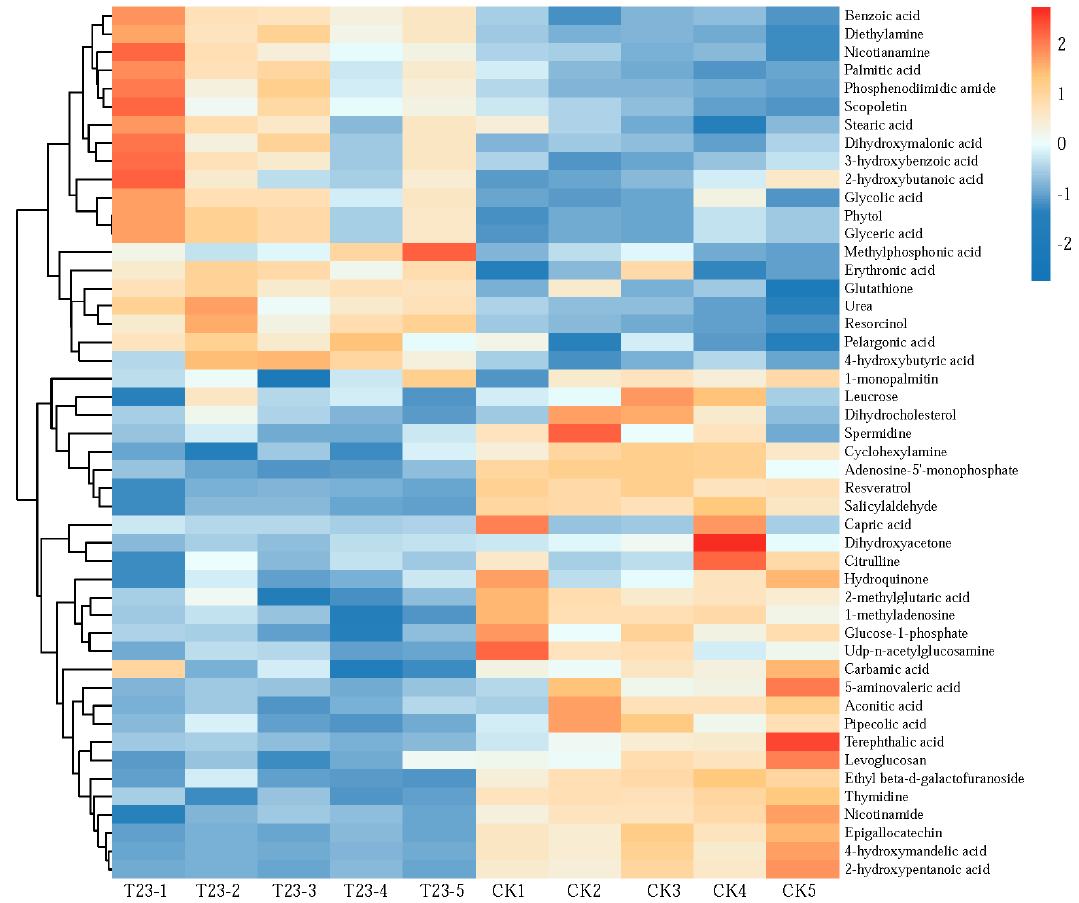
Figure 5. Heat map of metabolite contents in the rhizosphere of the muskmelon. Yellow represents high content and blue represents low content. high content and blue represents low